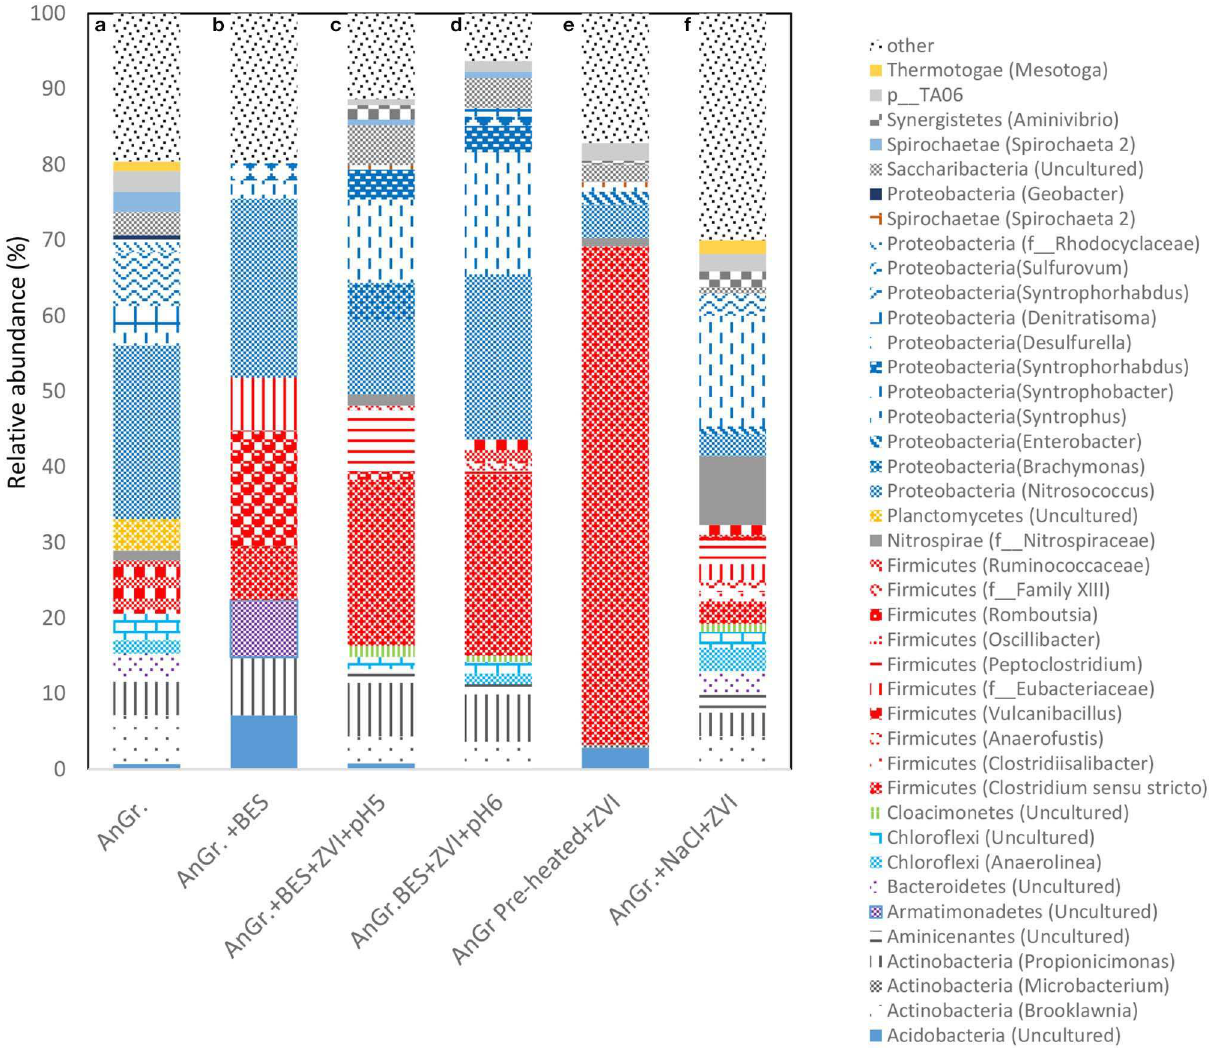
FIGURE 11 | Relative abundance of bacterial community at the phylum and genus level at the end of batch experiment for (a) anaerobic granular sludge (AnGr.), (b) anaerobic granular sludge and BES (AnGr. + BES), (c) anaerobic granular sludge, BES, ZVI and operation at pH 5–6 (AnGr. + BES + ZVI + pH 5), (d) anaerobic granular sludge, BES, ZVI and operation at pH 6–6.5 (AnGr. + BES + ZVI + pH 6), (e) anaerobic granular sludge previously heated, ZVI and operation at pH 6–6.5 (AnGr. pre-heated + ZVI), (f) anaerobic granular sludge exposed to 90 g NaCl/L and ZVI (AnGr. NaCl +